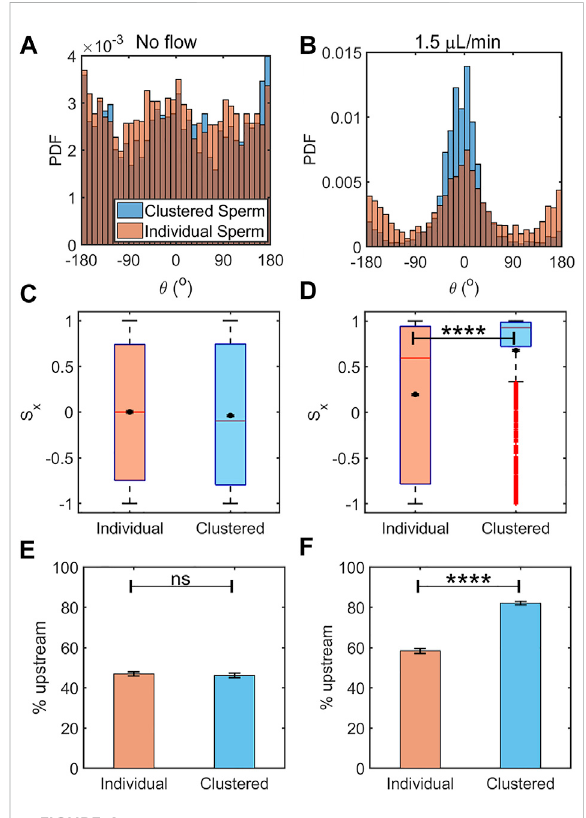
Clustered sperm exhibited greater rheotactic responses than individual sperm. Histogram of orientation angle between the clustered and individual sperm in the absence of fl ow (A) (N ≈ 2,800 cells for each) and under an intermediate fl ow rate of 1.5 μ L/min (B) (N ≈ 2,900 cells for each). Box plot along with mean of the sperm upstream orientation component ( S x ) under no fl ow (C) and an intermediate fl ow rate of 1.5 μ l/min (D) . The means are shown by a black dot. The box plot shows the median, 25%, and 75% quartiles; whiskers show smallest and largest data within 1.5 interquartile ranges below 25% and above 75% quartiles respectively; data beyond the whiskers are outliers and shown by +. Percentages of sperm oriented upstream, individual vs. clusteredspermunderno fl ow (E) (N ≈ 4,300cells)and fl owrateof 1.5 μ L/min (F) (N ≈ 3,500 cells). The error bars represent